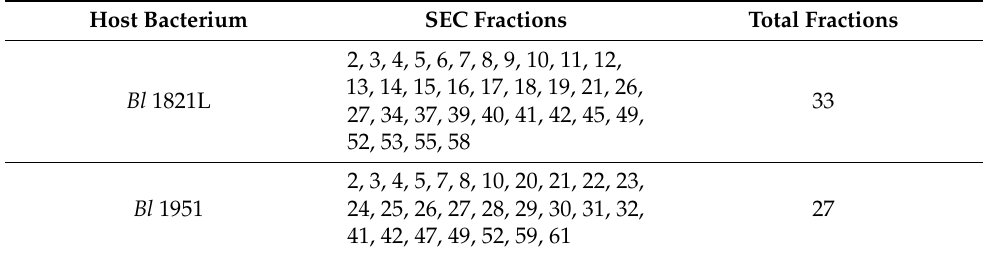
Table 1. Bl 1821L SEC active fractions of the assay test.